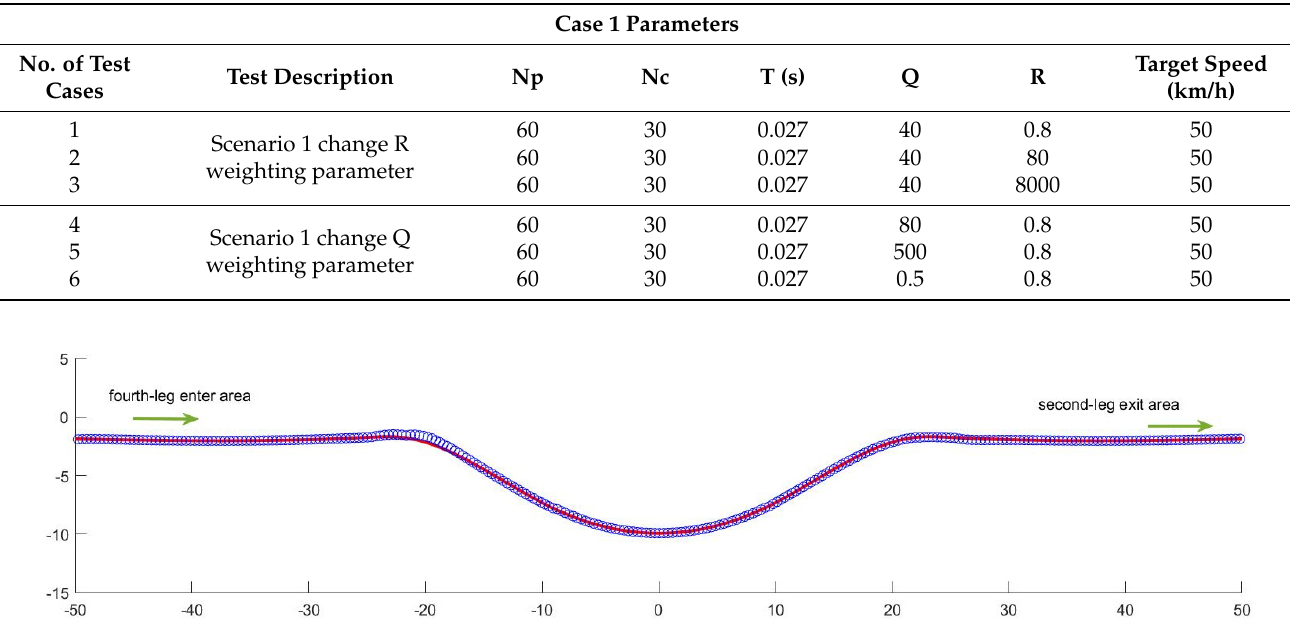
Table 1. Fourth-leg enter, second-leg exit MPC tracking changing parameters. Case 1 Parameters